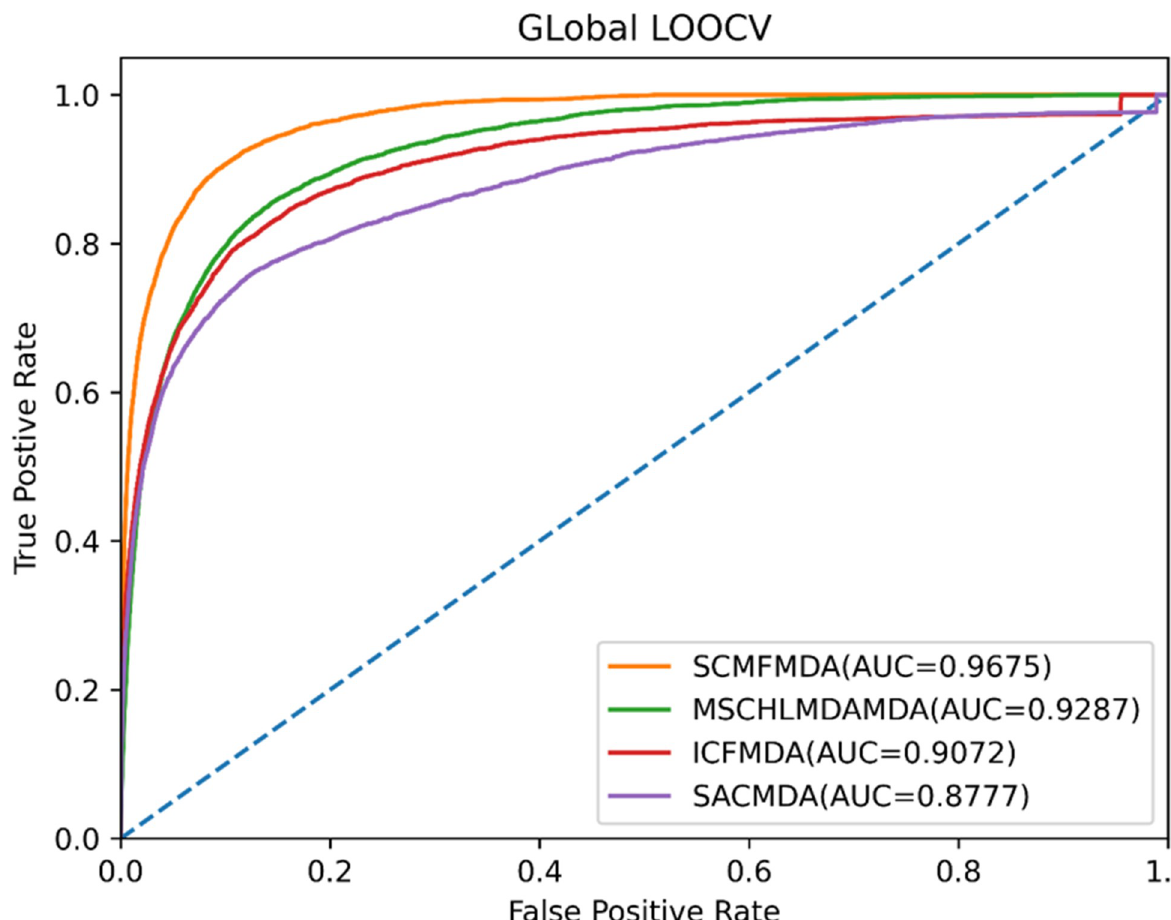
Fig 4. AUC of global LOOCV compared with those of MSCHLMDA, ICFMDA and SACMDA.